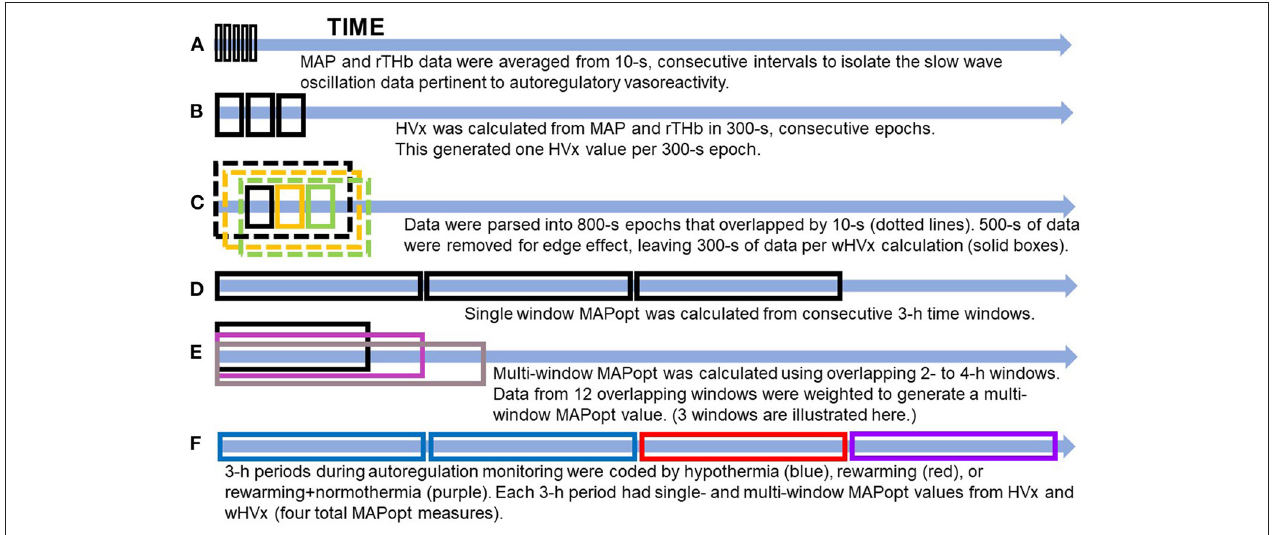
FIGURE 1 | Illustration of data processing. (A) The data were filtered to remove high-frequency waveforms, including those associated with pulse and respiration. (B) The hemoglobin volume index (HVx). (C) The wavelet hemoglobin volume index (wHVx). (D) Single-window, optimal mean arterial blood pressure (MAPopt). (E) Multi-window MAPopt. (F) MAPopt values were calculated in consecutive 3-hour periods that were coded by the neonate’s core temperature. Boxes are not to scale. MAP, mean arterial blood pressure; rTHb, NIRS relative total tissue hemoglobin.